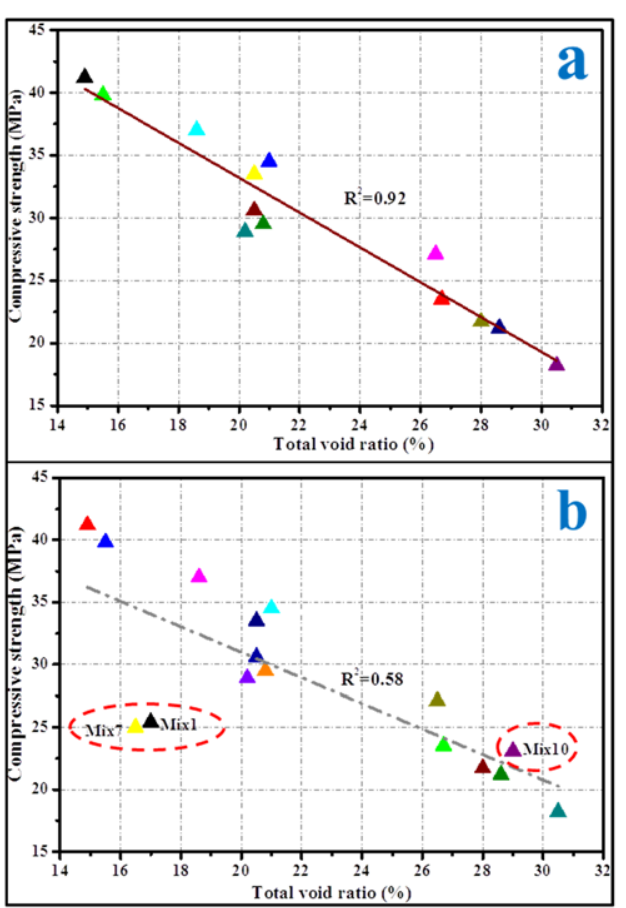
Figure 6. Correlation between total void ratio and 28-day compressive strength of porous mortar and each sample is represented by a colored triangle; the red circles represent groups of samples with significantly reduced correlations. ( a ) All designs in Table 4 except for Mix1, Mix7 and Mix10; ( b ) all designs in Table 4.